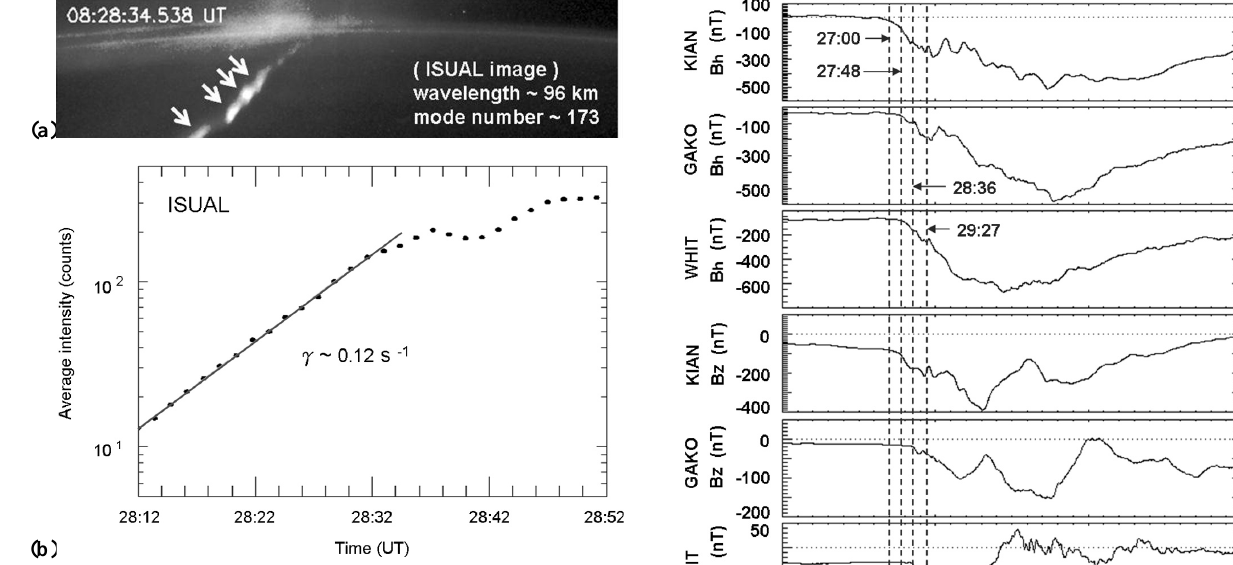
Fig. 6. (a) Auroral arc structure observed by the ISUAL Imager aboard the FORMOSAT-2 satellite, and (b) the temporal evolution of the average arc intensity.